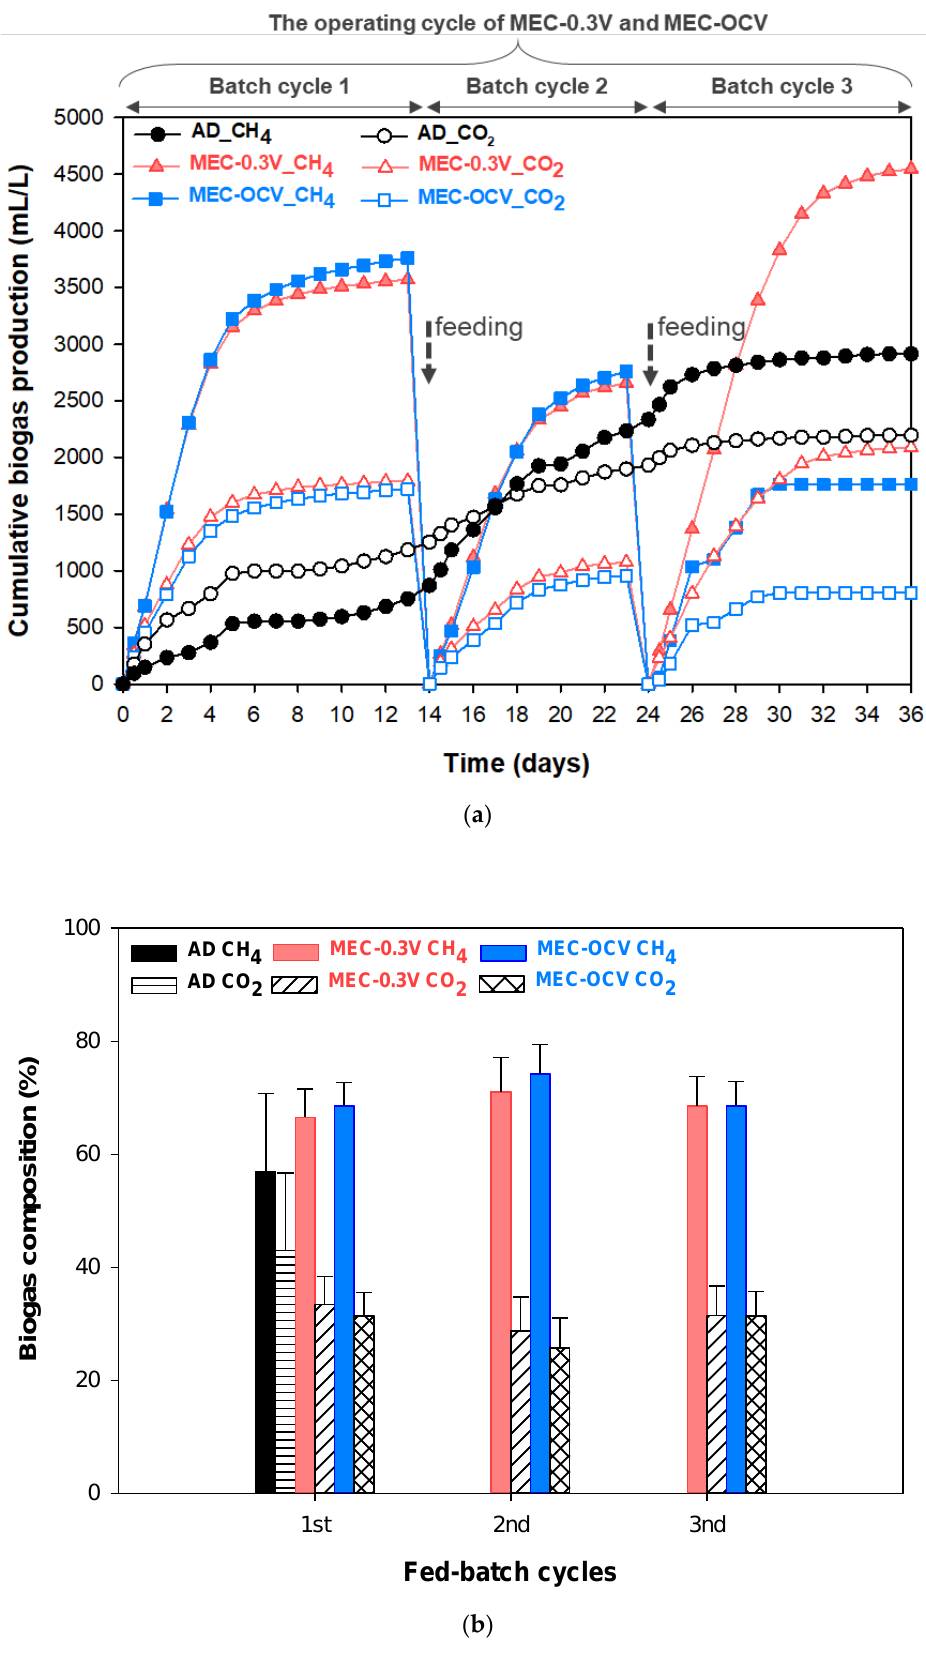
Figure 2. Daily biogas production ( a ) and total biogas composition ( b ).